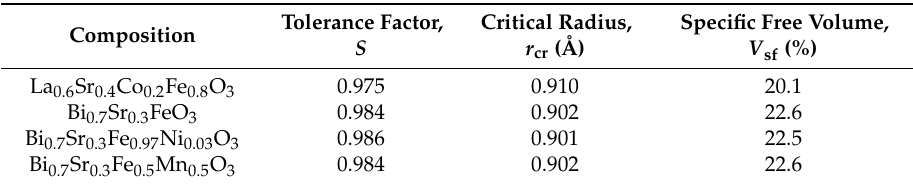
Table 6. Calculated tolerance factor, critical radius and specific free volume of LSCF6428, S30, S30N3, and S30M50 cathode materials.